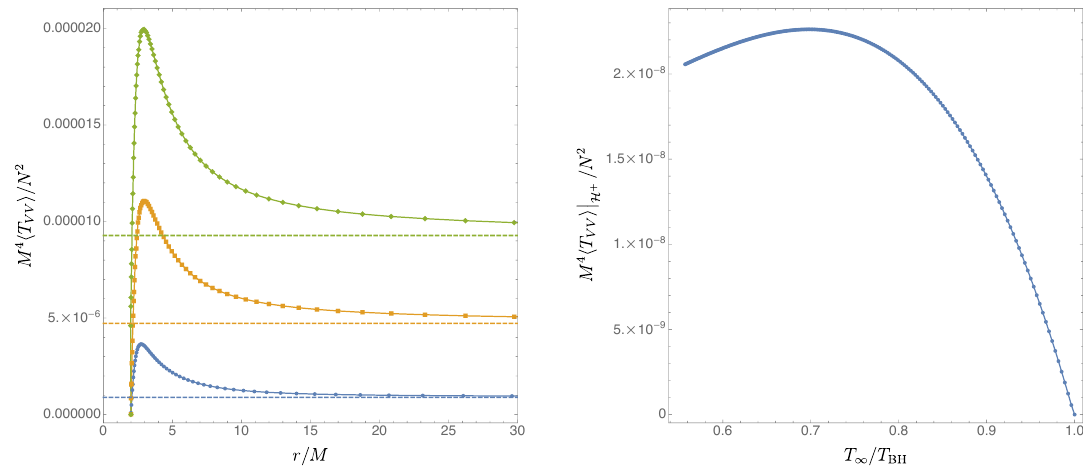
Figure 3 . Left: The null-null component of the holographic stress energy tensor, h T V V i , as a function of r=M . Each curve corresponds to a di(cid:11)erent value of T 1 =T BH . From bottom to top, we have T 1 =T BH = 0 : 557103 ; 0 : 844773 ; 1. The horizontal dashed lines indicate the asymptotic value of h T V V i computed for a planar black hole at temperature T 1 . Right: The null-null component of the holographic stress energy tensor evaluated on H + , h T V V ij , as a function of several values of H + T 1 =T BH . As expected, h T V V ij is non-zero except for the Hartle-Hawking state corresponding H + to T 1 =T BH = 1. In both plots we have used r 0 = 2 M